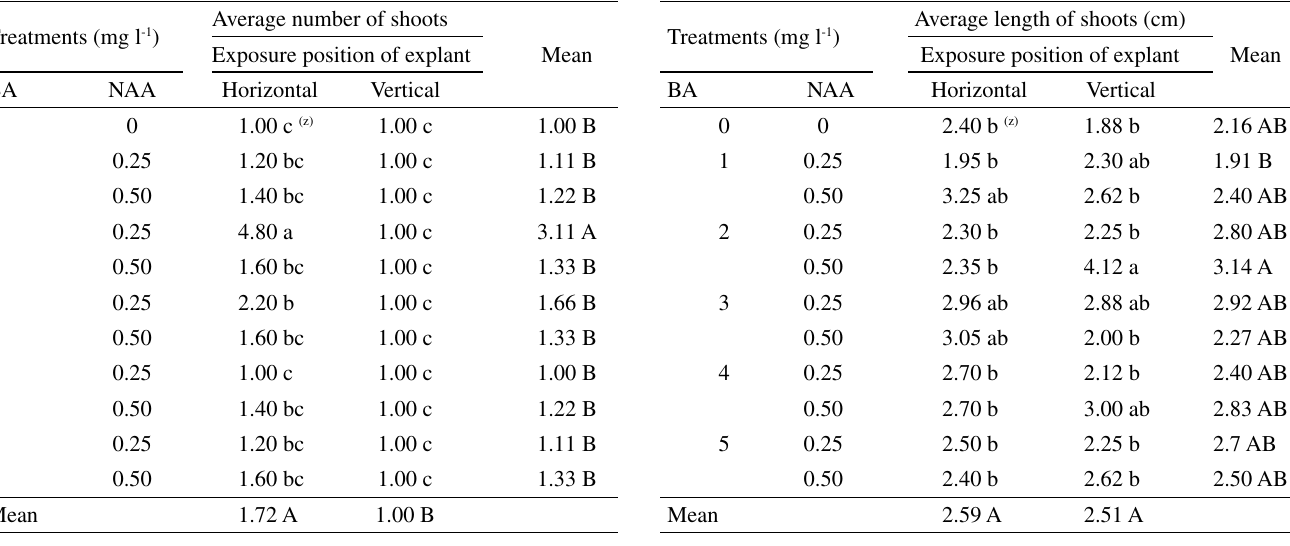
Table 4 - The interaction effect of different concentrations of BA and NAA, and exposure position of explants on the length of shoots in ‘Green’